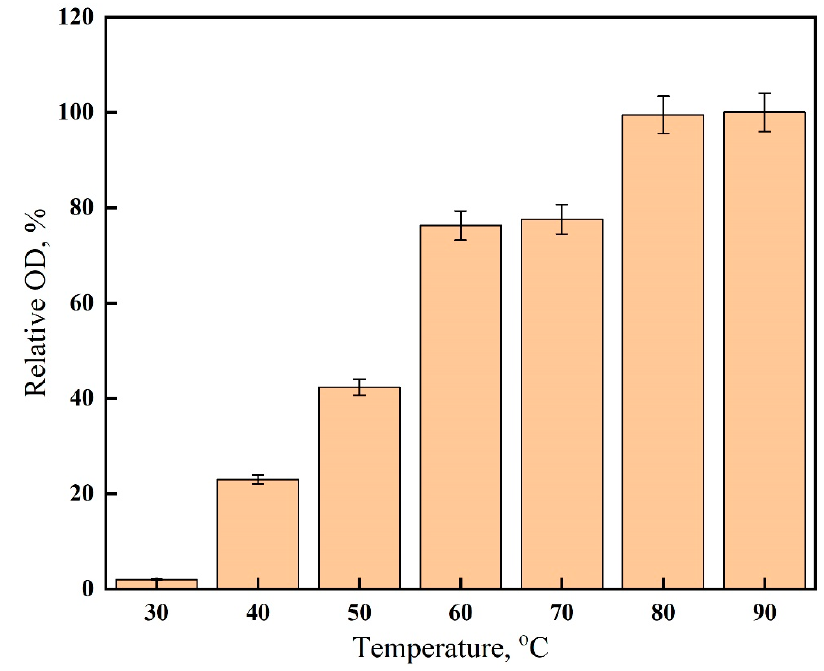
Figure 5. Effect of temperature on the color evolution of gelatin-silver reagent. Conditions: A 1 mL of the reaction mixture contained 250 µL maltose (0.1 mM), 250 µL of 0.2 M Tris–HNO 3 buffer PH 8.5, 500 µL gelatin-silver reagent (1:3), incubated at different temperature, cooling, recorded the absorbance at 434 nm. Each point represents the mean of three experiments ± SE.